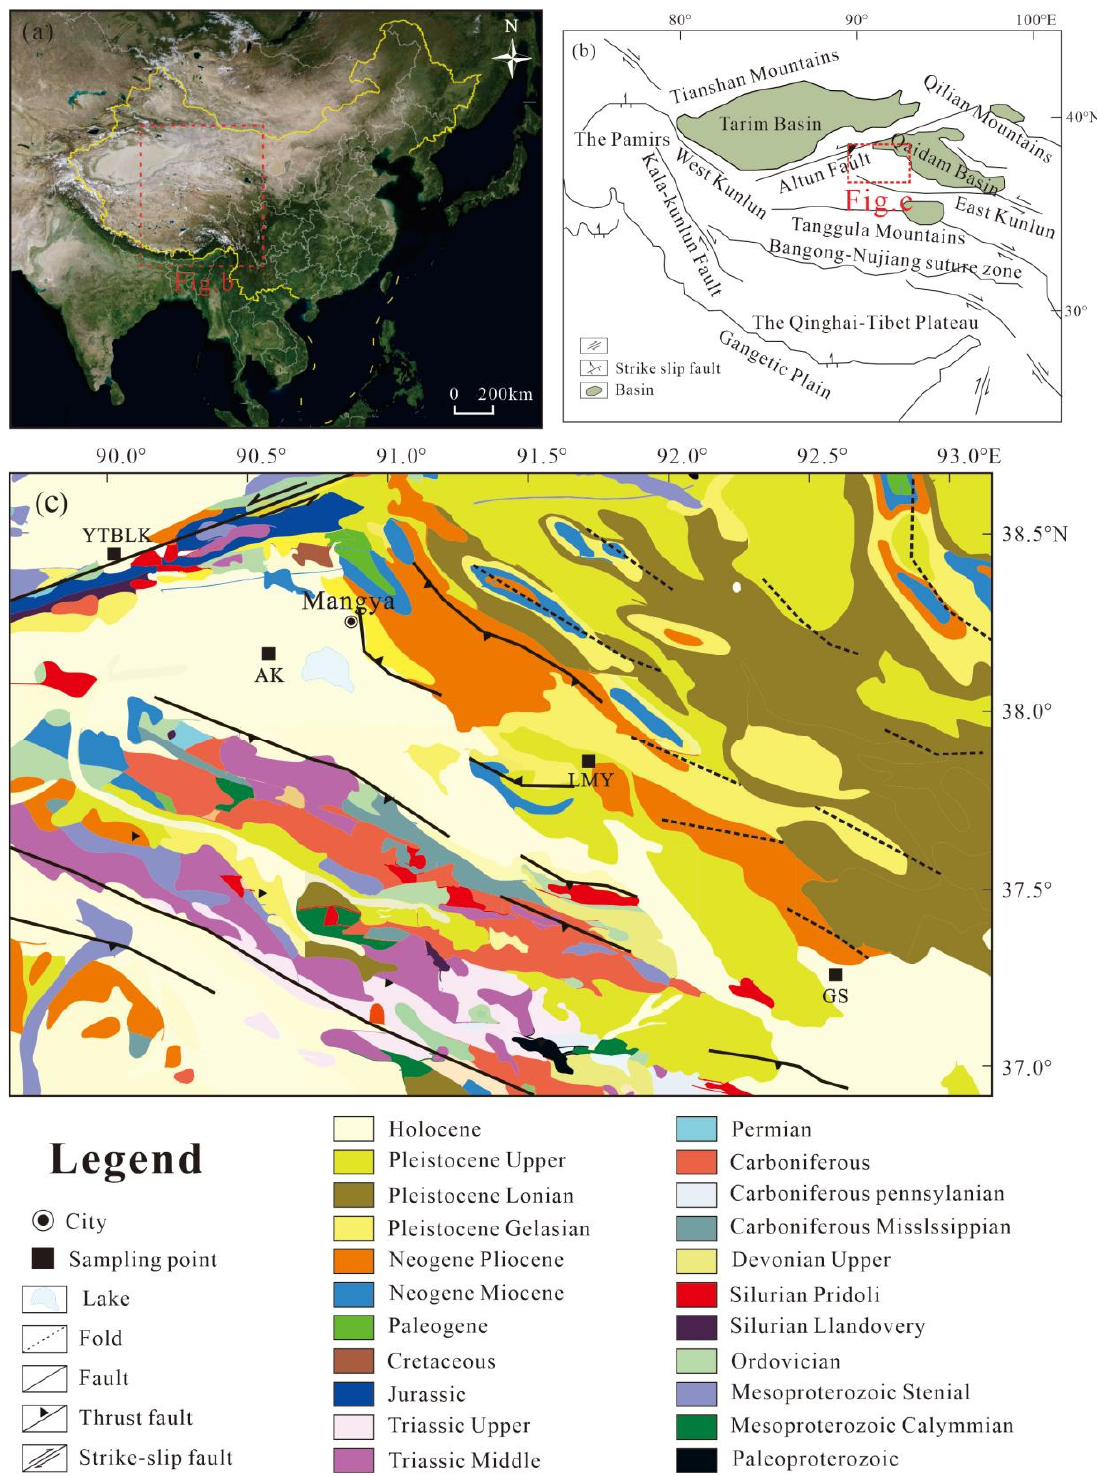
Figure 1. A plot depicting the sampling site distribution. ( a ) A geographical and spatial distribution map of China; base map: Google Earth satellite imaging map. ( b ) Tectonic unit division of the Qaidam Basin and its adjacent region. ( c ) The geological structure and the sampling points in the study region; base map: the 1:2,500,000 geological structure map of